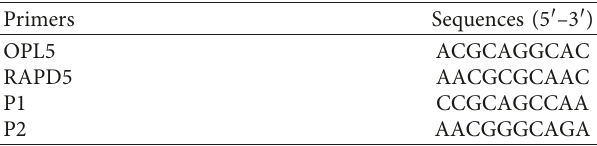
Table 2: Primers used for the RAPD-PCR method.